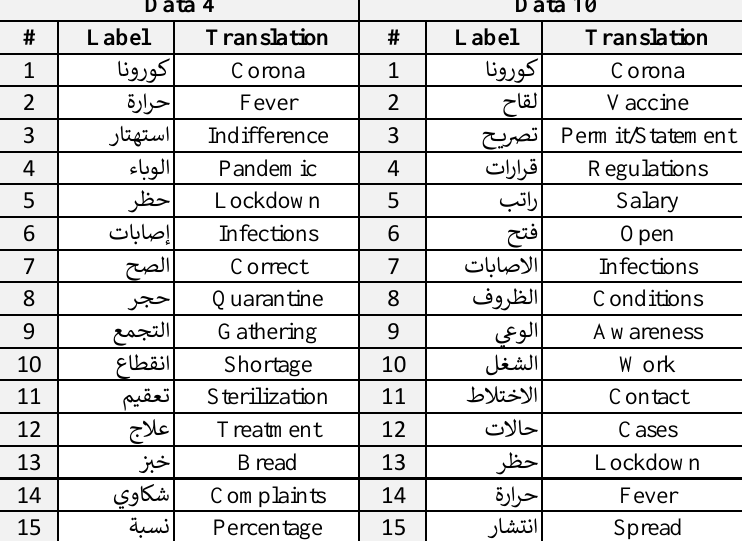
Figure 5. Features details and translation for Data 4 and